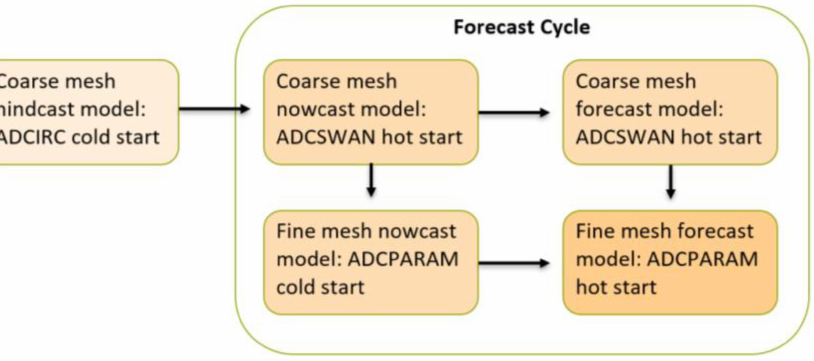
Figure 5. Sequence of model events for a MMEMS forecast run. Coarse mesh and fine mesh forecast models run up to 7 times per cycle; once for every meteorological ensemble